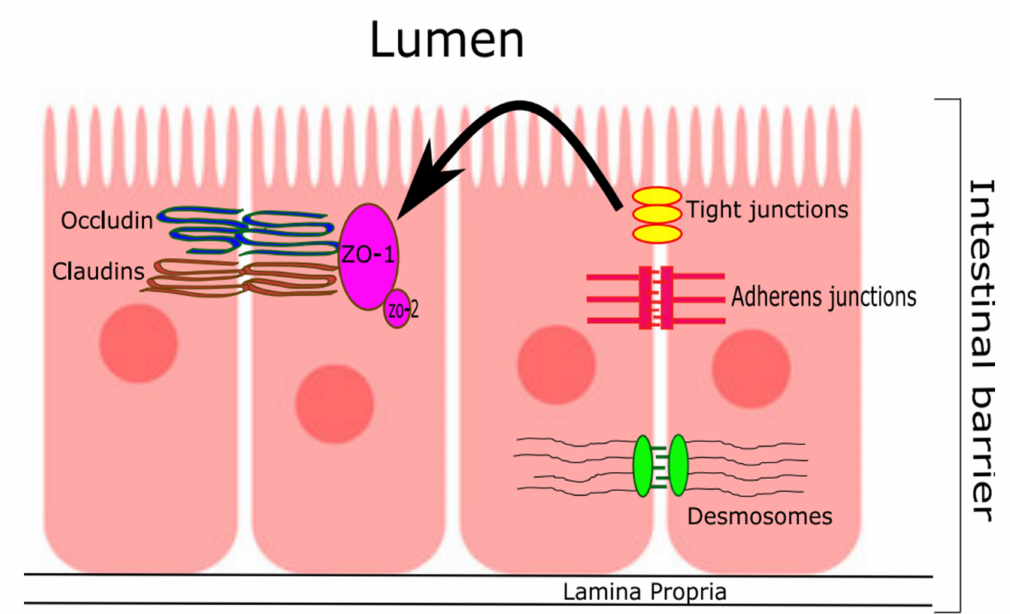
Figure 1. The apical junctional complex and tight junctions in the small intestine. ZO-1 = Zonula occludens-1; ZO-2 = Zonula occludens-2.